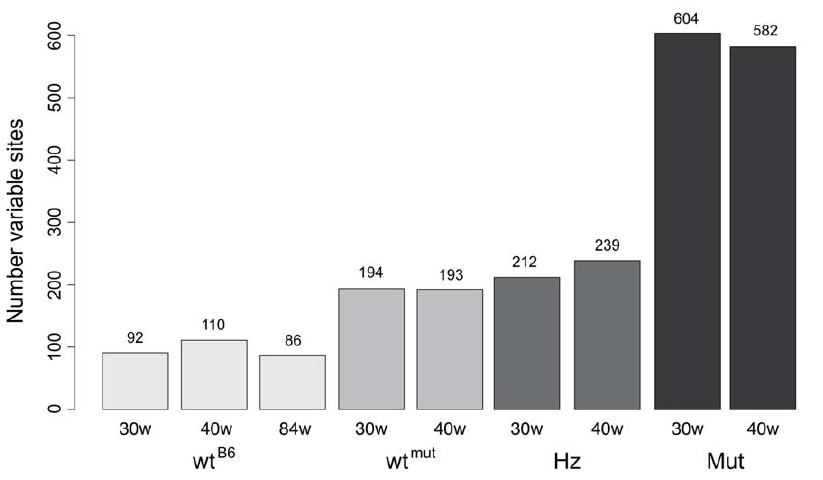
Figure 3. Number of mutations with a frequency of at least 0.5% in each sample. (Abbreviations: wt B6 = C57Bl/6N animal, wt mut = wildtype sibling of the mtDNA mutator mouse, Hz = heterozygous sibling of the mtDNA mutator mouse, Mut = mtDNA mutator mouse, 30w & 40w =30 weeks of age and 40 weeks of age, respectively).